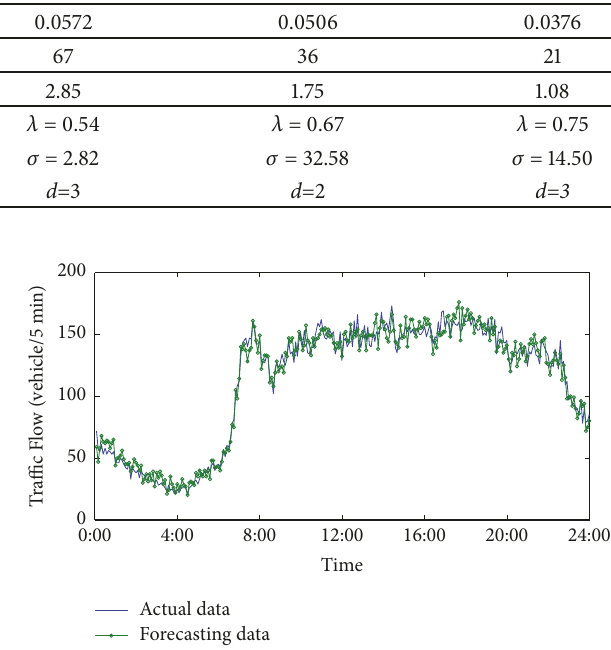
Figure 10: The forecasting performance of detector NBDX16 (2) .